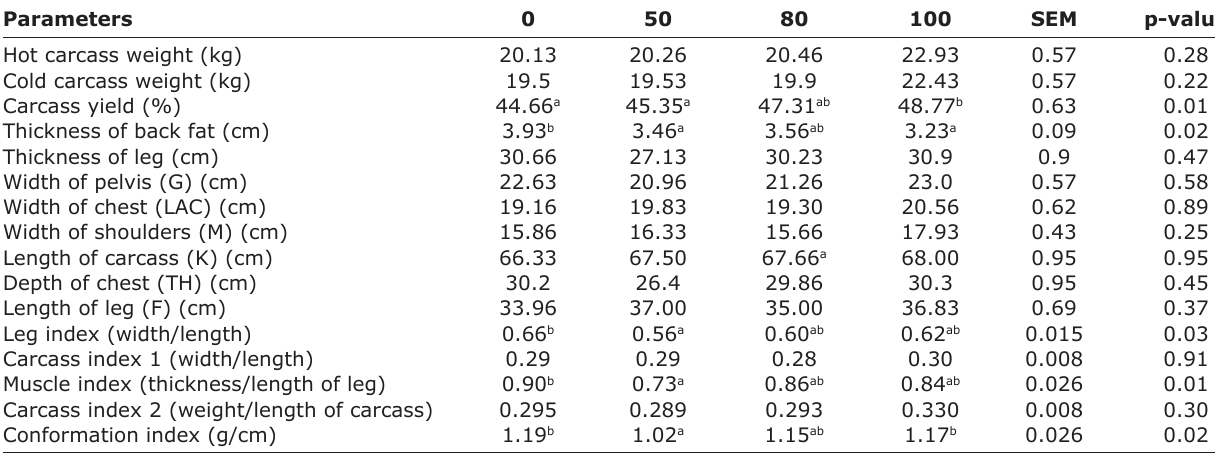
Table-7: Effects of incorporating DPs and cull dates on the characteristics of Ouled Djellal lamb carcasses. Parameters